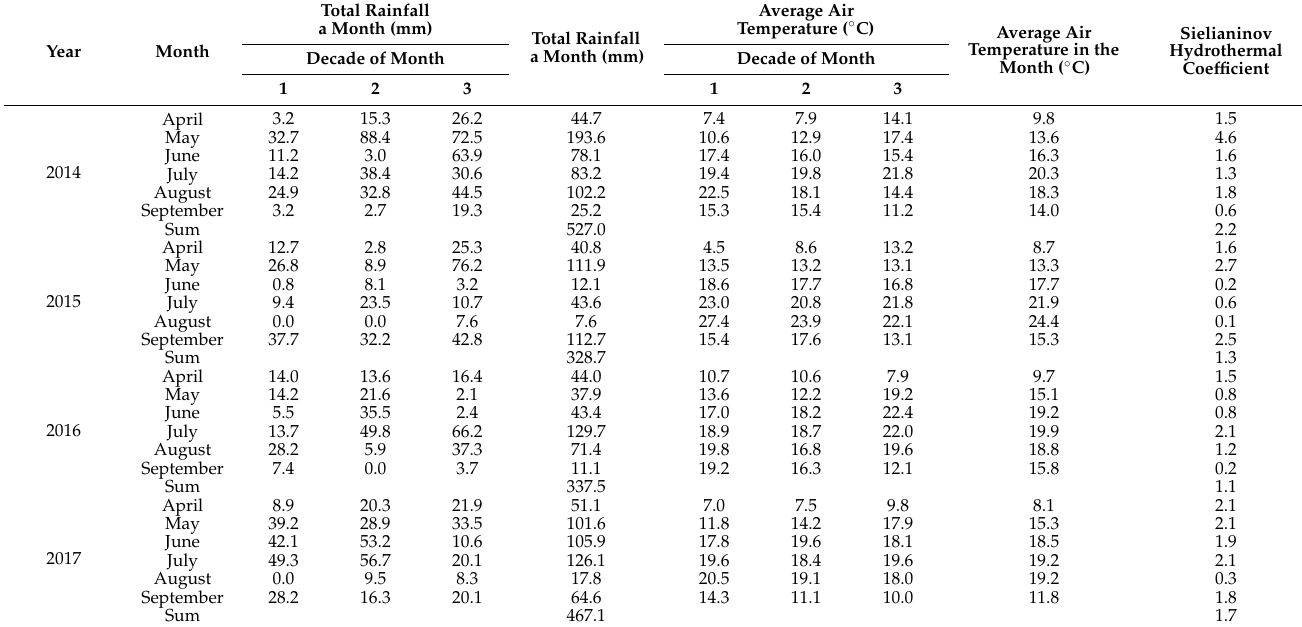
Table 7. The sum and distribution of rainfall and average air temperature during the growing season of hop in the years 2014–2017 according to the meteorological station in